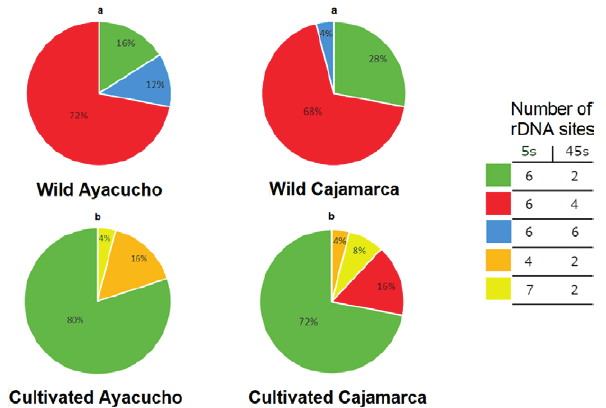
Figure 3 Th e frequency of 5s and 45s rDNA sites observed in the 25 metaphases of each goldenberry population. Diff erent letters at the top of each frequency circle show signifi cant diff erences (Fish- er’s Exact Test, p<0.05).